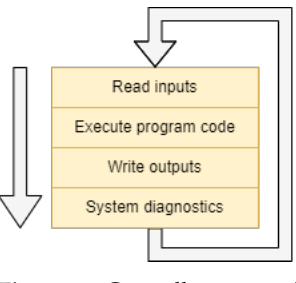
Figure 10. Controller scan